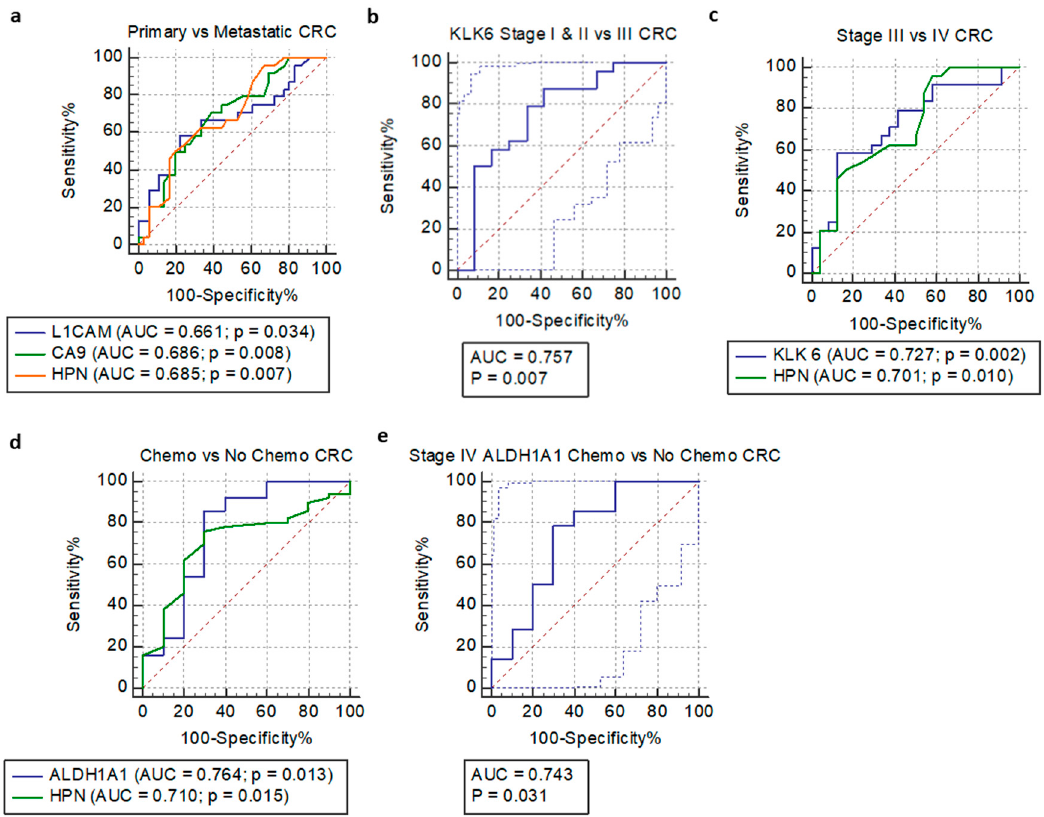
Figure 3. Receiver operating characteristic curves of selected serum biomarkers: (1) Primary versus metastatic CRC: ( a ) L1CAM / CA9 / HPN; (2) Number stage: ( b ) KLK6 stage I & II vs. IV; ( c ) KLK6 / HPN stage III vs. IV; (3) Chemotherapy versus no chemotherapy: ( d ) ALDH1A1 / HPN; and (4) Stage IV chemotherapy versus no chemotherapy: ( e ) ALDH1A1.